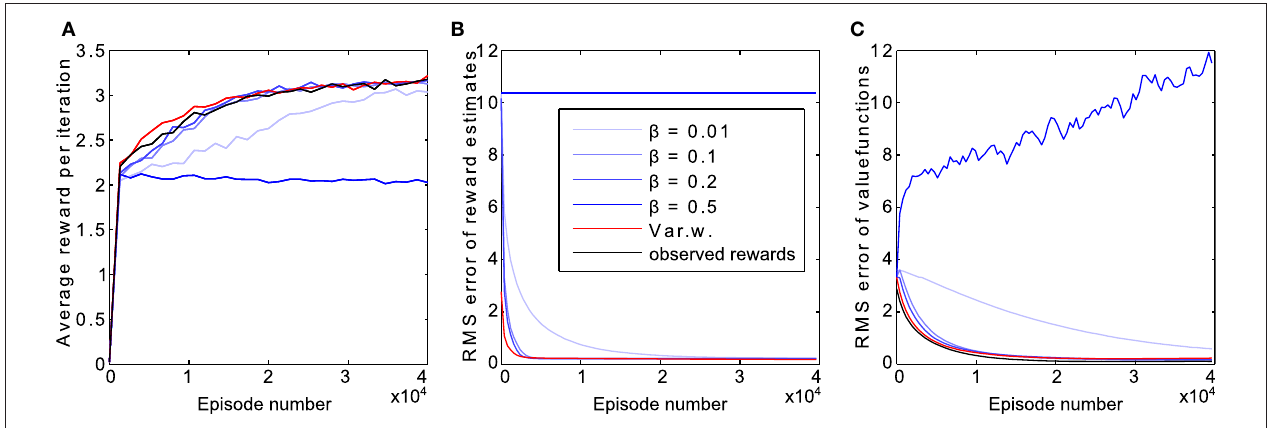
Figure 6 | Comparison of learning progress. (A) Effect of different learning rates and the variance weighted learning (“Var.w.”) on the accumulated reward over episodes for the simulated foraging agent for the case of only knowing global reward Gt. For comparison, a case where the rewards given to each module were known is shown as the “observed